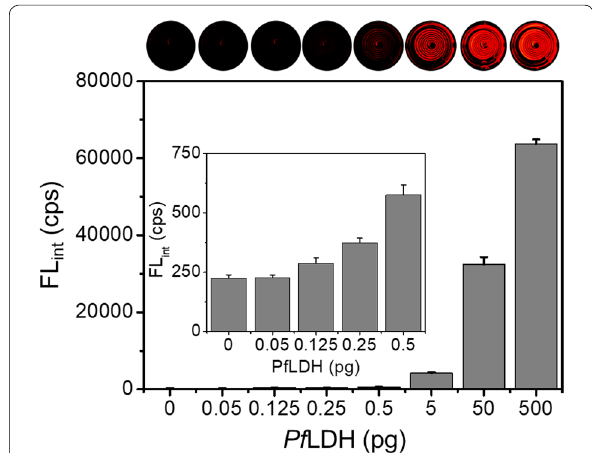
Fig. 4 Diagnosis of Pf LDH using the microfluidic microplate-based immunoassay. Chemiluminescence intensity (n chemiluminescence images of the microfluidic microplate to the detection of Pf LDH